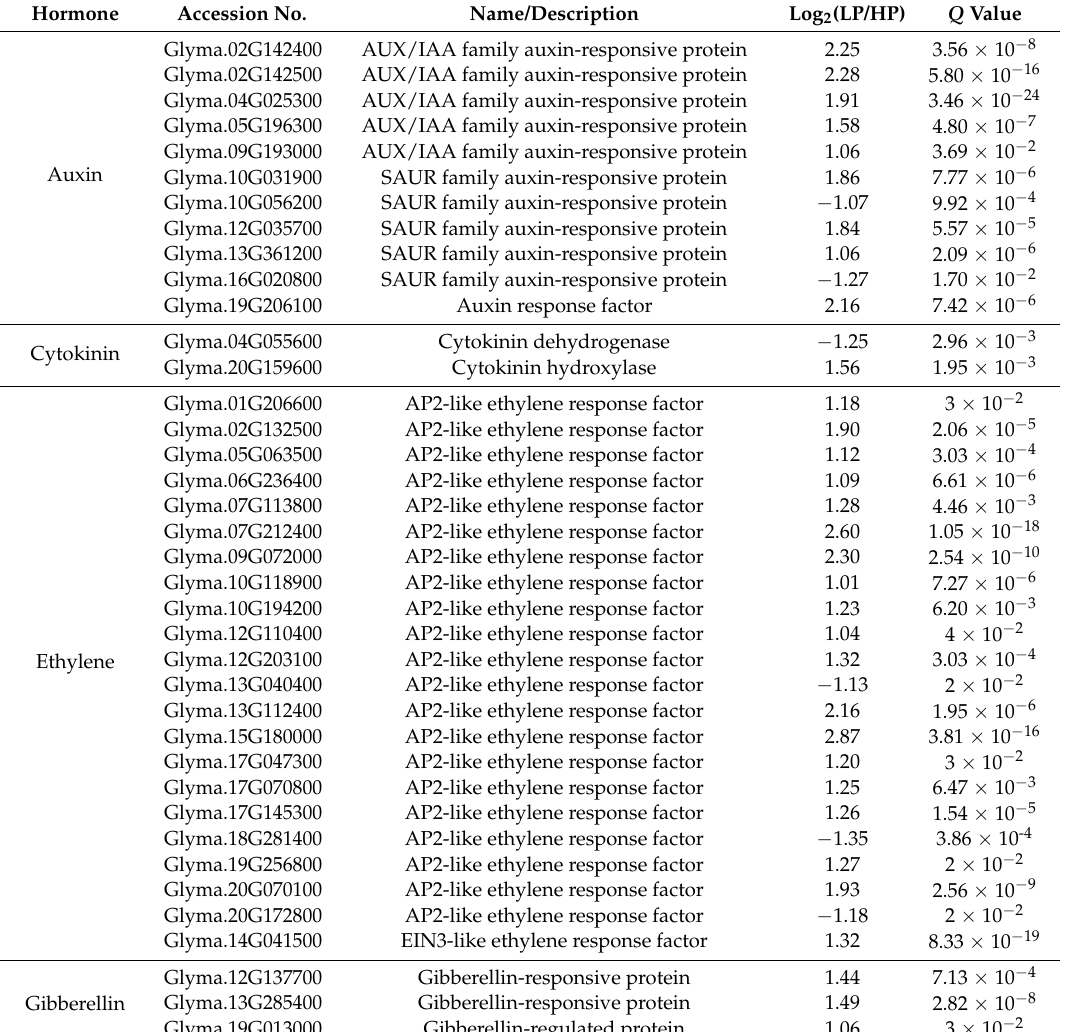
Table 4. Differentially expressed genes involved in hormonal